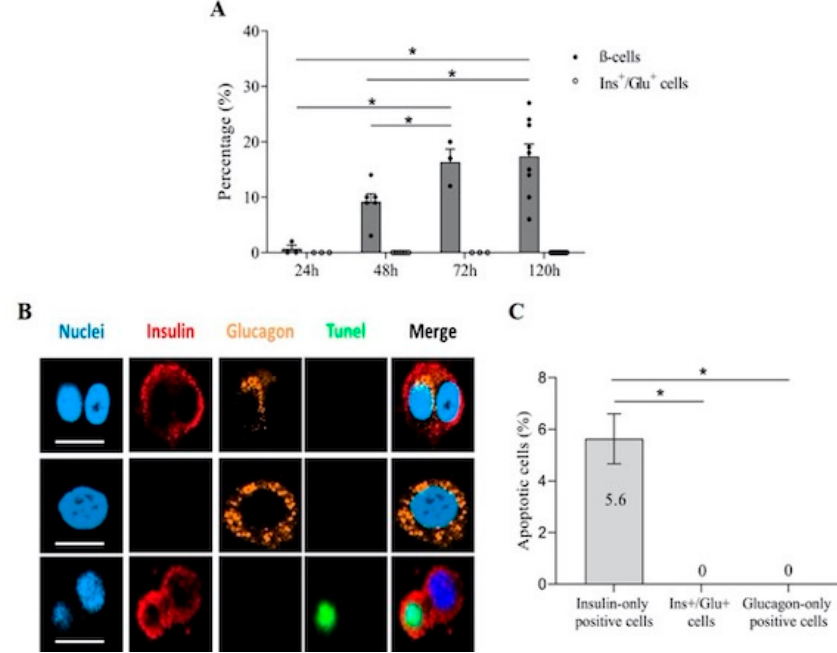
Figure 3. Pro-inflammatory cytokines induce apoptosis in β - but not in Ins + /Glu + cells. ( A ) Percentage of β - and Ins + /Glu + cells with signs of apoptosis in whole human islets at different time points of pro-inflammatory cytokine exposure, quantified by electron microscopy. ( B ) Representative images of confocal microscopy analysis of dispersed human islet cells, stained for DAPI (nucleus, blue), insulin (red), glucagon (yellow) and TUNEL (apoptotic nucleus, green), after 48 h cytokine exposure (scale bar corresponds to 10 μ m). ( C ) Percentage of insulin-only positive cells, Ins + /Glu + cells and glucagon-only positive cells stained by TUNEL. Percentages are relative to total endocrine cell number. * p < 0.05.